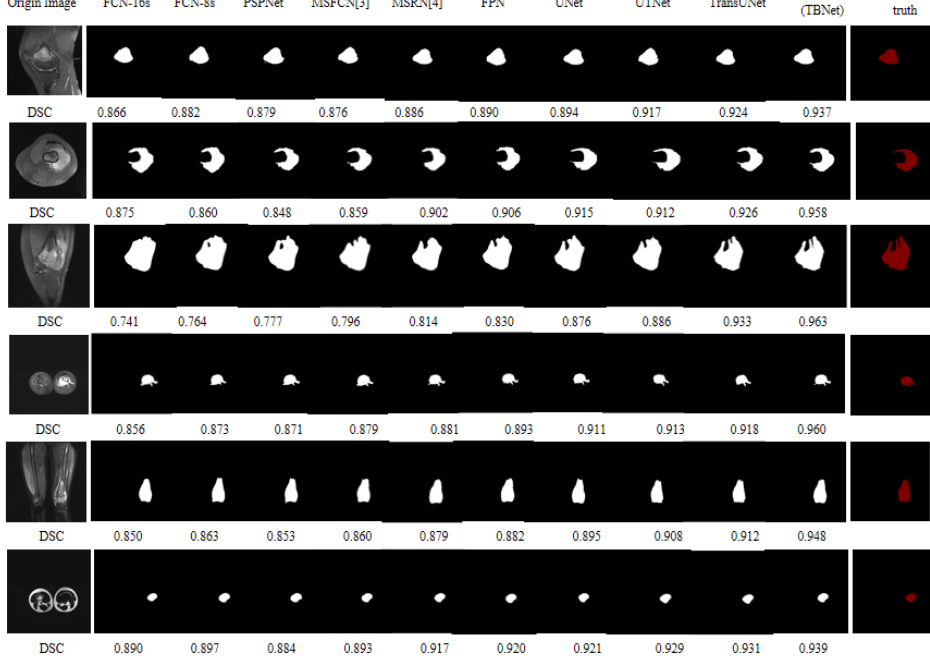
Figure 9. Comparison of different models for the segmentation of MRI images of osteosarcoma. Similarly, for the same osteosarcoma images with complex edge blurring character- istics as in cases 3 and 4 above, we selected the following six examples of osteosarcoma images with blurred edges and used TransUNet, and our proposed TBNet for image seg- mentation, respectively. As show n in Figure 10, our method can segment the boundary of the lesion region more effectively and precisely. Figure 10. Segmentation effect with blurred edges. We measured segmented data to quantitatively compare the effectiveness of the var- ious methods by comparing several classical comparative metrics. The osteosarcoma task is shown in Table 4. Our proposed model TBNet performs well overall in the task. Several metrics of our scheme are the highest. For example, ACC, IOU, DSC, and Re reach 0.997, 0.915, 0.949, and 0.969, respectively. The performance of the UNet network is also